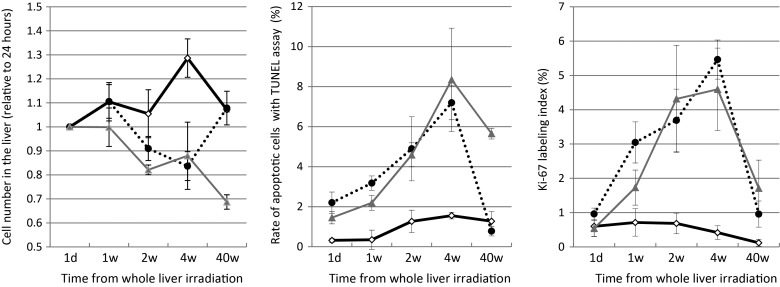
Pathological changes in liver cells following whole-liver irradiation for the respective time-points (control: bold line, 15 Gy: dotted line, 30 Gy: gray line). (A) The liver cell counts (relative to 24-h time-point) in the 15 Gy group after 4 and 40 weeks were 0.84 ± 0.15 and 1.08 ± 0.14, respectively, and the corresponding cell counts in the 30 Gy group were 0.88 ± 0.29 and 0.69 ± 0.07, respectively. The counts in the 15 Gy group 40 weeks post irradiation returned to the control group levels (1.07 ± 0.02). (B) The ratio of apoptotic cells in the irradiated groups significantly increased 4 weeks post irradiation (7.2 ± 0.9% in the 15 Gy group and 8.3 ± 2.6% in the 30 Gy group). The ratio in the 15 Gy group after 40 weeks (2.3 ± 0.6%) returned to the control group level (1.8 ± 0.9%), but that in the 30 Gy group remained at the high level (5.7 ± 0.4%). (C) The labeling indexes for Ki-67 immunohistochemical staining in the irradiated groups increased by 1 week post irradiation and reached the peak level after 4 weeks, irrespective of irradiation doses.